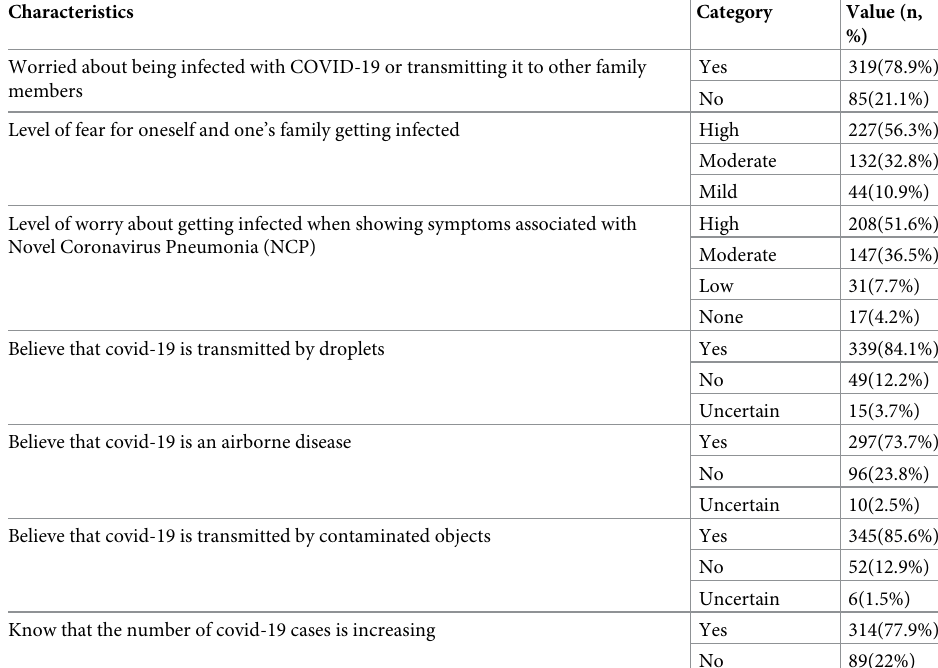
Table 2. Clinical, COVID-19, and substance-related characteristics of individuals living with a disability.